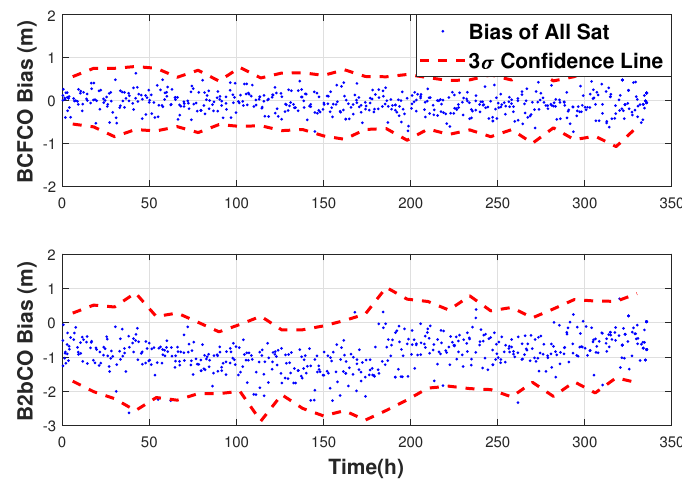
Figure 6. The bias of BCFCO and